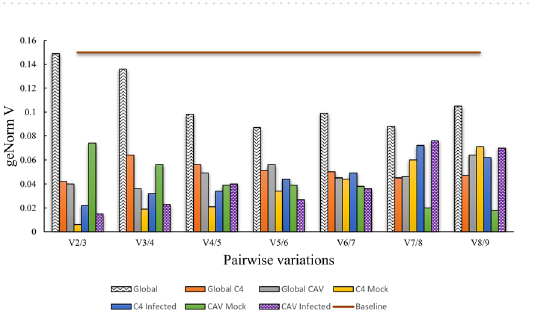
Figure 3. GeNormPlus-derived expression stability for each candidate reference gene for Musa acuminata leaf tissues. Values of M below a 0.5 cutoff indicate high stability rate.